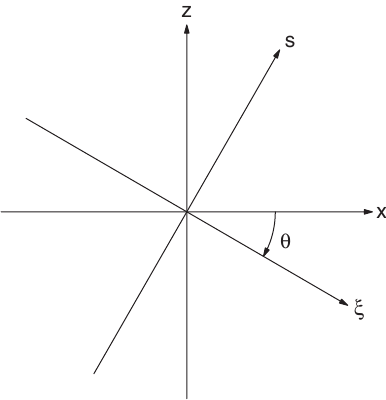
FIG. 19. Configuration of the x - z frame and (cid:3) - s